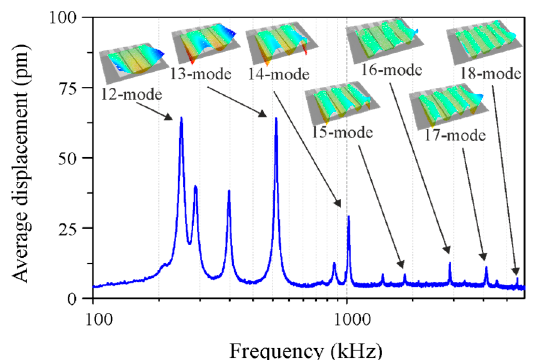
Figure 4. Average displacement per unit voltage from the optical characterization of the 500 × 700 × 20 µm 3 cantilever in isopropanol. The measured modal shapes are shown next to each peak.